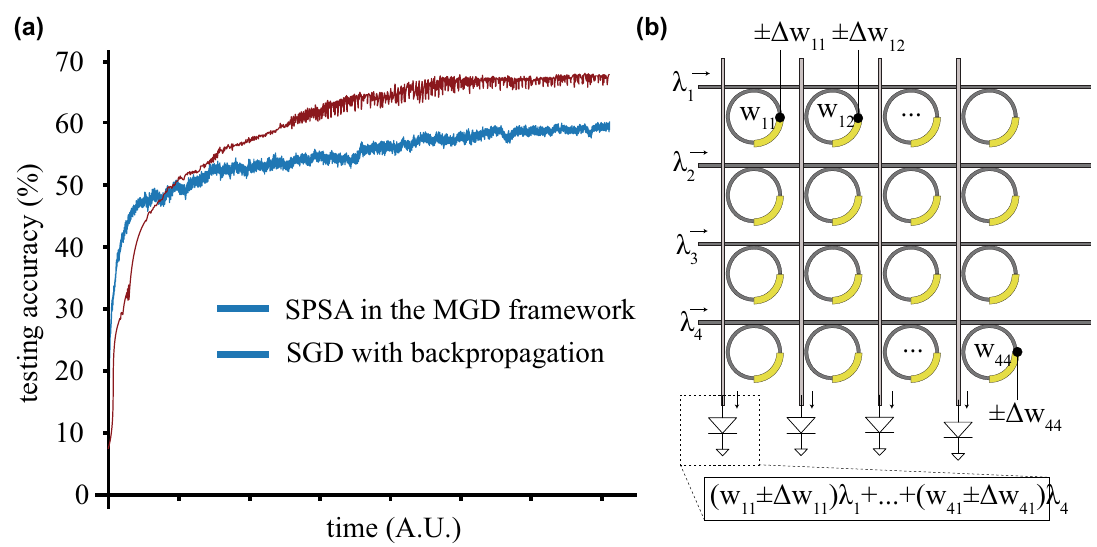
Figure 3: (a) CIFAR10 testing accuracy versus time during training with SPSA in the MGD framework, as compared to SGD with backpropagation.